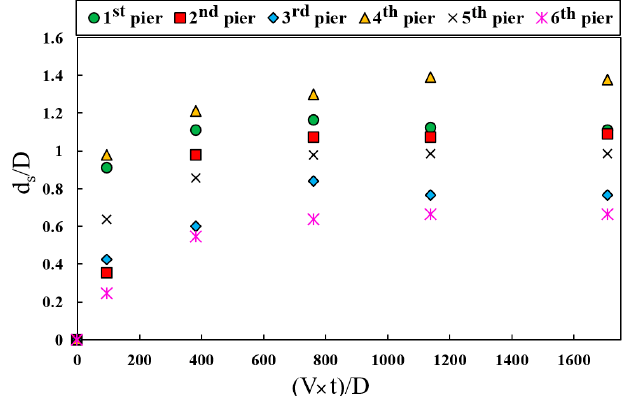
Figure 6. Dimensionless scour depths at various dimensionless